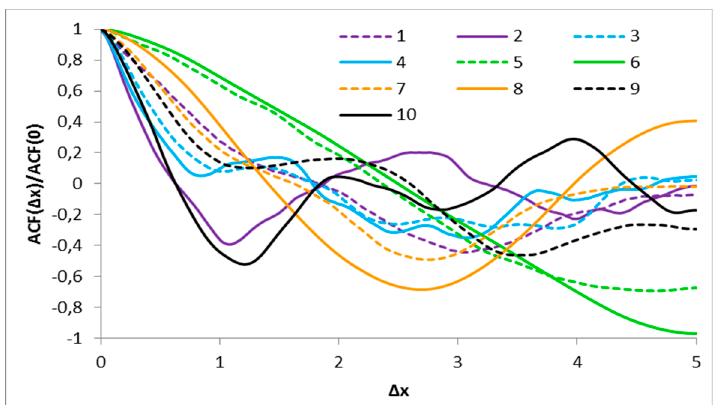
Figure 2. The normalized autocorrelation functions ACF ( ∆ x ) / ACF (0) as function of the distance ∆ x (labelled by the No. of Barton and Choubey’s [4] profile; see also Appendix A).